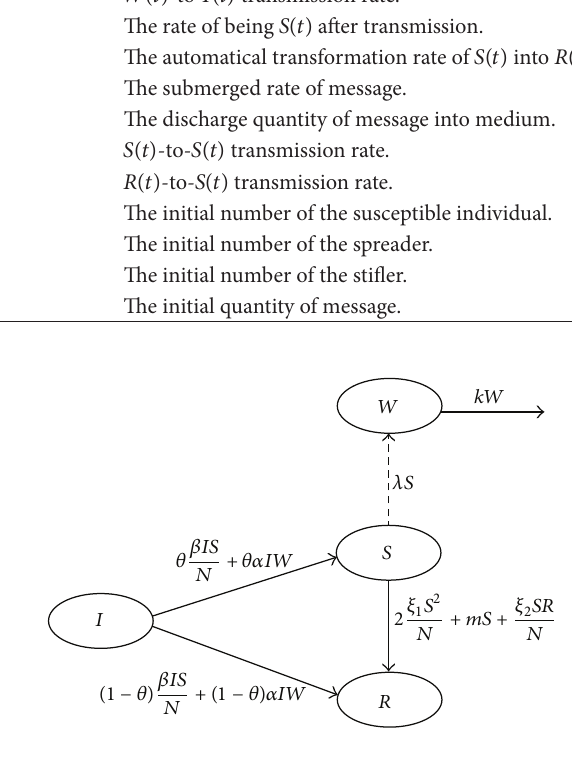
Figure 1: Transfer diagram on the dynamical transmission of rumor among